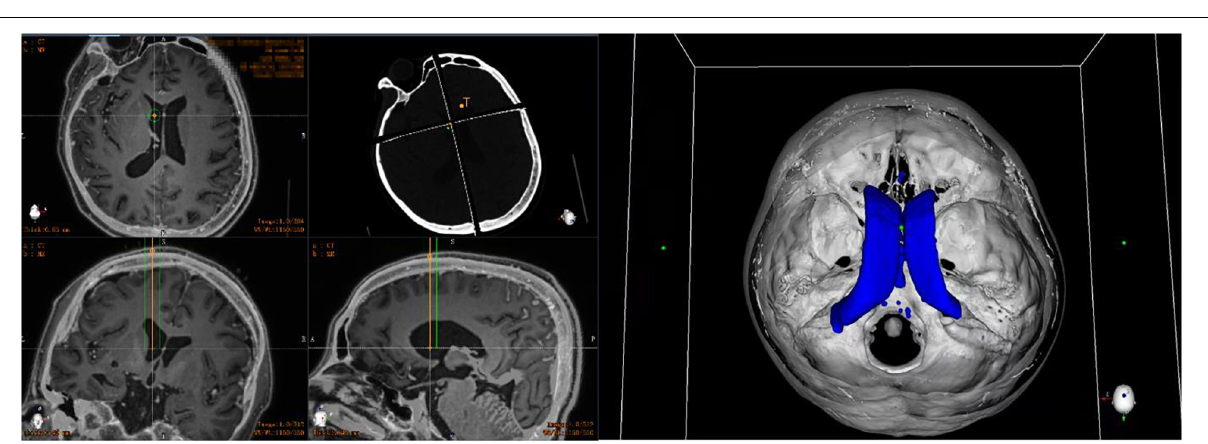
FIGURE 2 | Preoperative planning of robotic work platform: automatically calculate the 3D ventricle segmentation of the patient and plan the target and cranial path before surgery (the orange line represents the implanted drainage tube, the green line represents the safe distance for the drainage tube implantation, and the blue shape represents the ventricle of the